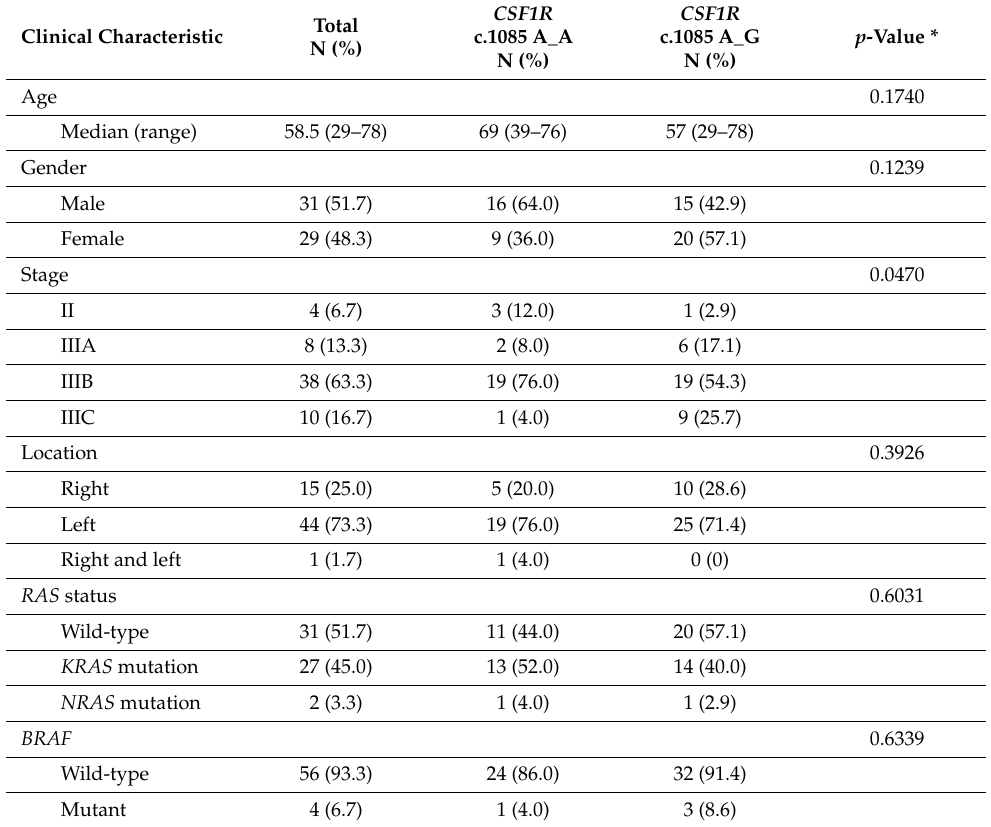
Table 1. Clinical characteristics of 60 CRC patients.